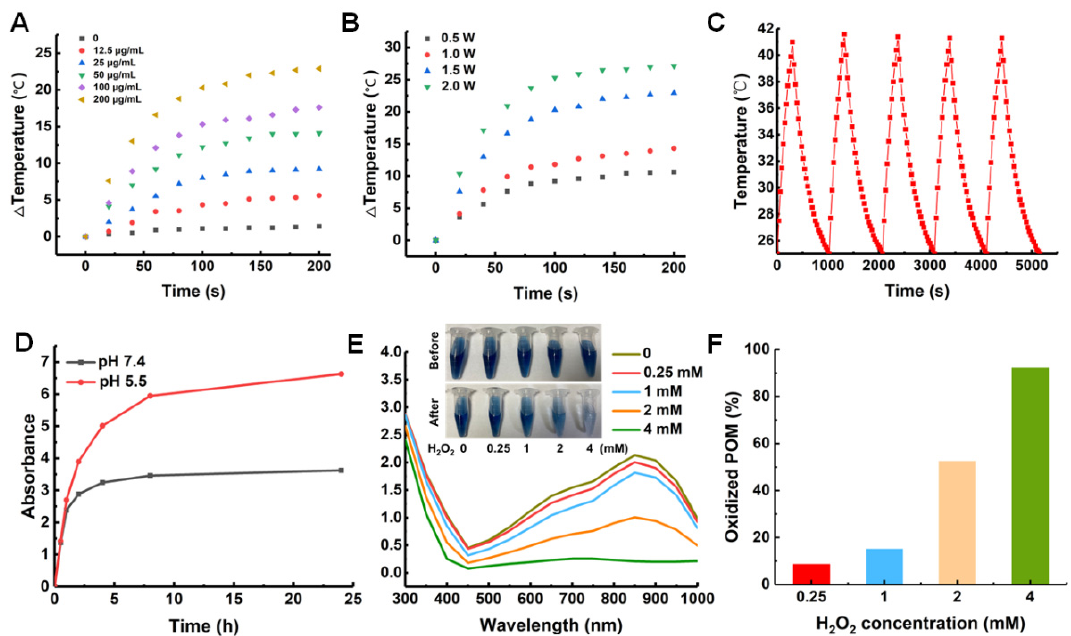
Figure 3. ( A ) Photothermal curves of ZCPH solutions of different doses upon an 808 nm irradiation. ( B ) Photothermal curves of ZCPH solutions upon 808 nm irradiation with different irradiation intensity. ( C ) The heating and cooling curves of ZCPH dispersions over five irradiation cycles. ( D ) Acid-responsive release behavior of CQ after ZCPHs were dispersed in PBS solutions of different pH values (pH = 7.4 and 5.5) at 37 °C. CQ at pH 5.5 condition displayed higher UV absorption than that in pH 7.4 condition. ( E ) The corresponding UV absorbance of POMs before and after incubation with H 2 O 2 at different concentrations. Insert is the color changes of POMs. ( F ) Quantitative analysis of oxidized POM according to the UV absorption in Figure E . The different colors in ( F ) corresponded to that in Figure E